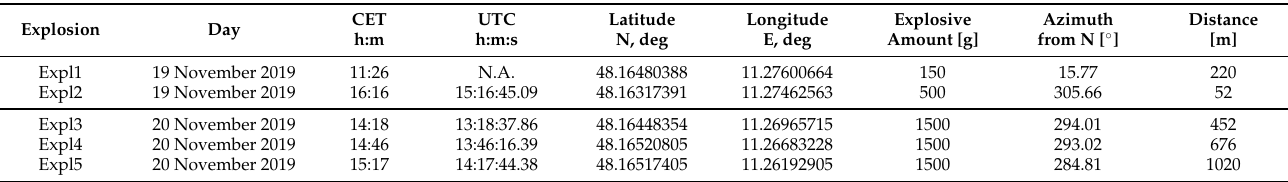
Table A1. A list of explosions used as active sources in the GOF experiment. Explosion time is specified both in Central European Time (CET) and Coordinated Universal Time (UTC). Azimuth and Distance refer to Rotaphone R10. Note that R10 was moved between Expl2 and Expl3 from the vault (48.162899 N, 11.2752 E) to the field deployment site (48.1628313 N, 11.27521977 E).